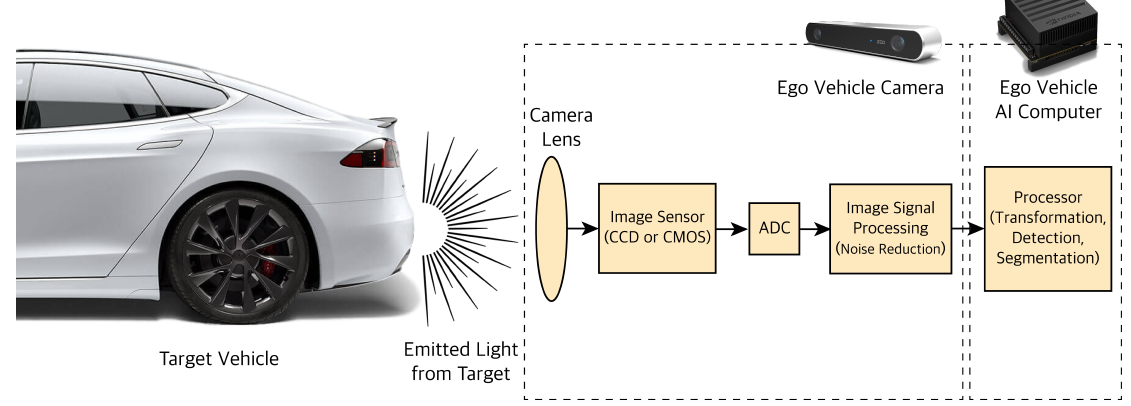
Figure 3. Camera sensor processing